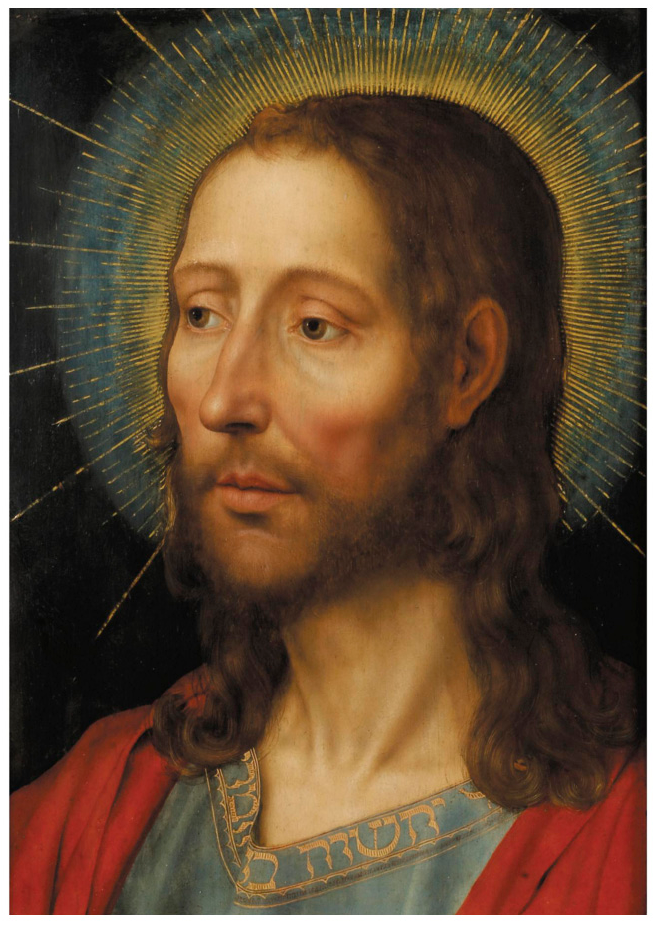
Figure 5. Quentin Massys. Christ , before 1529. Private collection [Sotheby’s (New York) 24 January 2008, lot 6]. Courtesy of Sotheby’s.